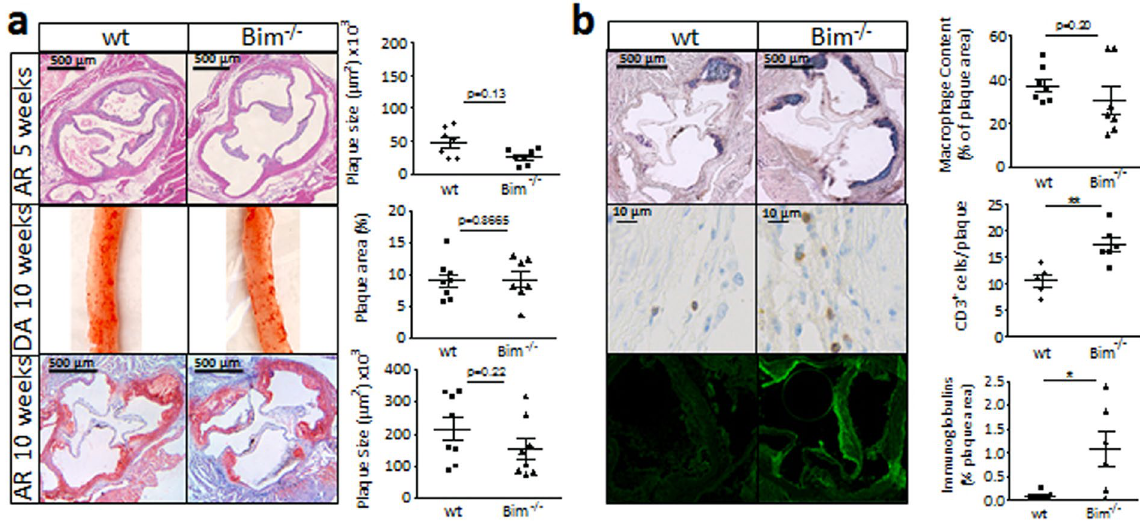
Figure 5. Plaques of bim − / − chimeras are marked by T cell accumulation and large Ig deposits. ( a ) Representative pictures of aortic root sections after 5 weeks and 10 weeks of WTD (top and bottom panel respectively), and descending aorta after 10 weeks of WTD (middle panel) reveal no differences in plaque size between wt and bim − / − chimeric mice. N = 7 (5 weeks WTD), n = 12 (10 weeks WTD). Data is shown as mean ± SEM. ( b ) Phenotypic analysis of atherosclerotic plaque composition in wt and bim − / − chimeric mice after 10 weeks of WTD (n = 12). Macrophage content was quantified by MOMA staining (top panel,